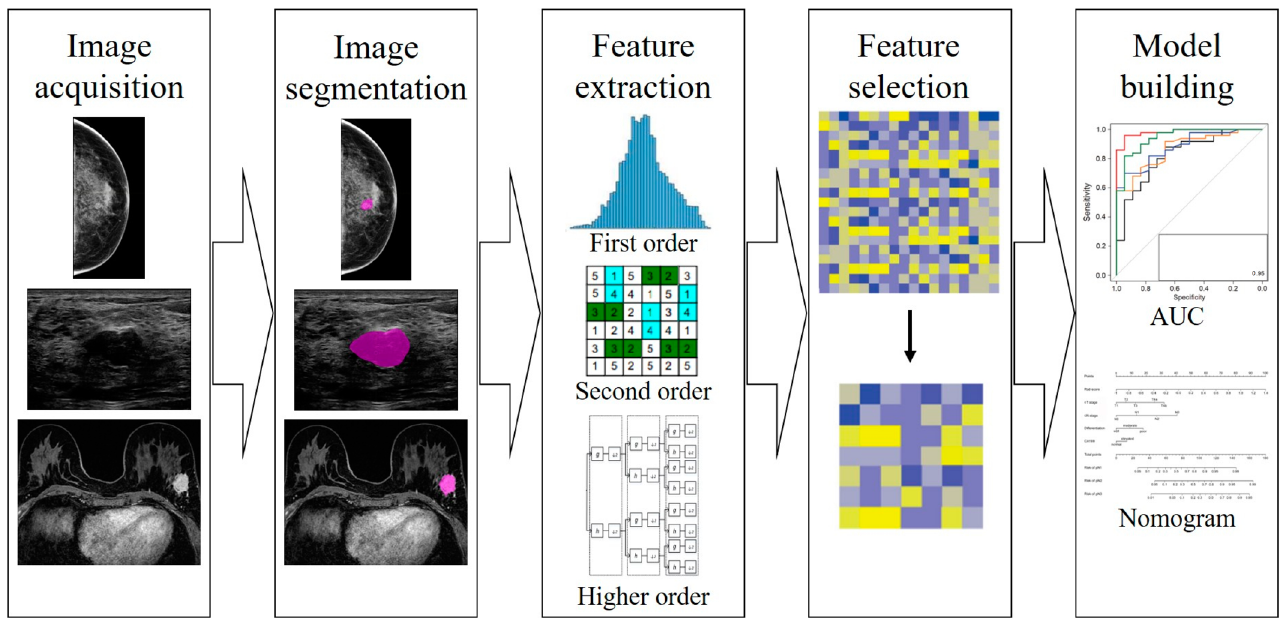
Figure 4. Different steps of radiomics workflow in breast imaging.